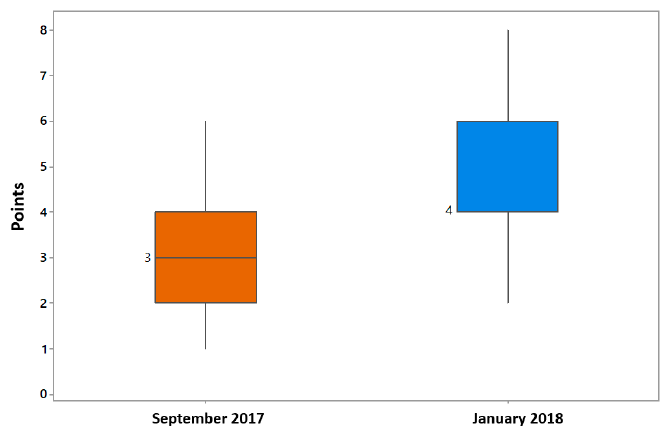
Figure 1. Boxplot diagram of student scores in September 2017 and January 2018.